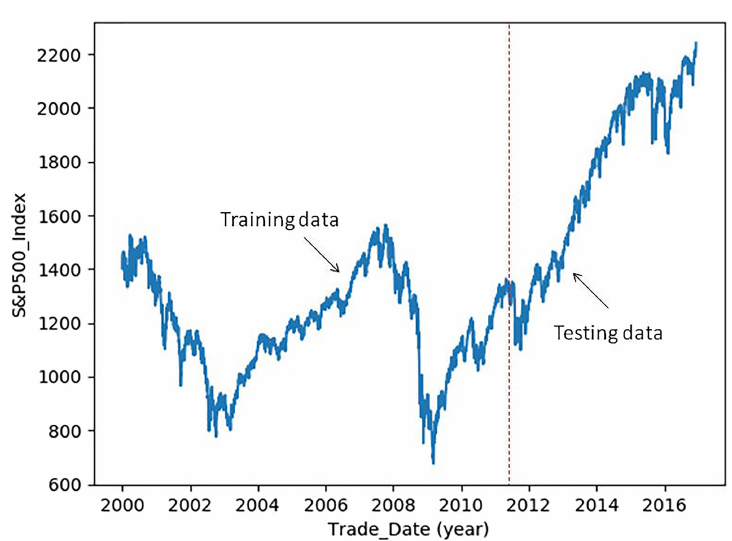
Figure 5. Daily close price